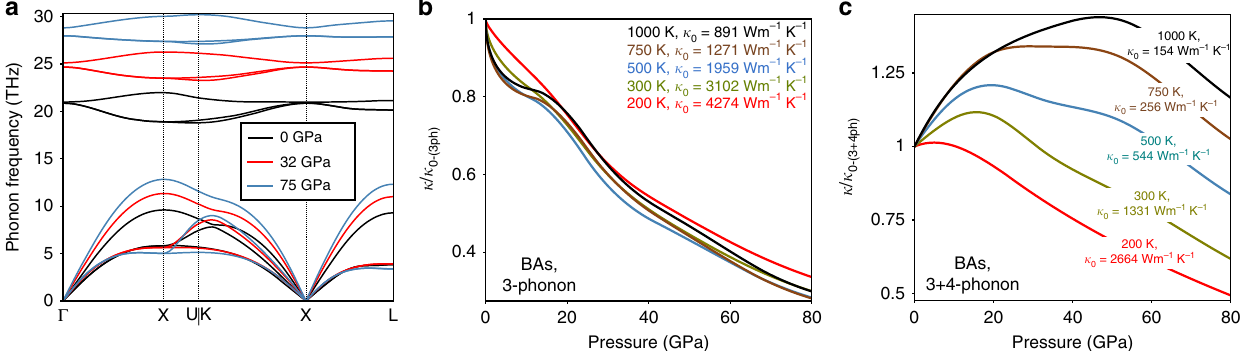
Fig. 2 Phonons and thermal conductivity of BAs under pressure. a Phonon dispersions of BAs at 300 K from 0 GPa to 75 GPa pressure. b Three-phonon limited κ of BAs versus pressure at different temperatures. c 3 + 4-phonon limited κ of BAs versus pressure at different temperatures. All κ curves are scaled by the corresponding zero-pressure values listed within the fi gures. BAs shows a rapidly decreasing three-phonon κ , while the 3 + 4-phonon value shows an unusual temperature-dependent non-monotonic behavior with pressure